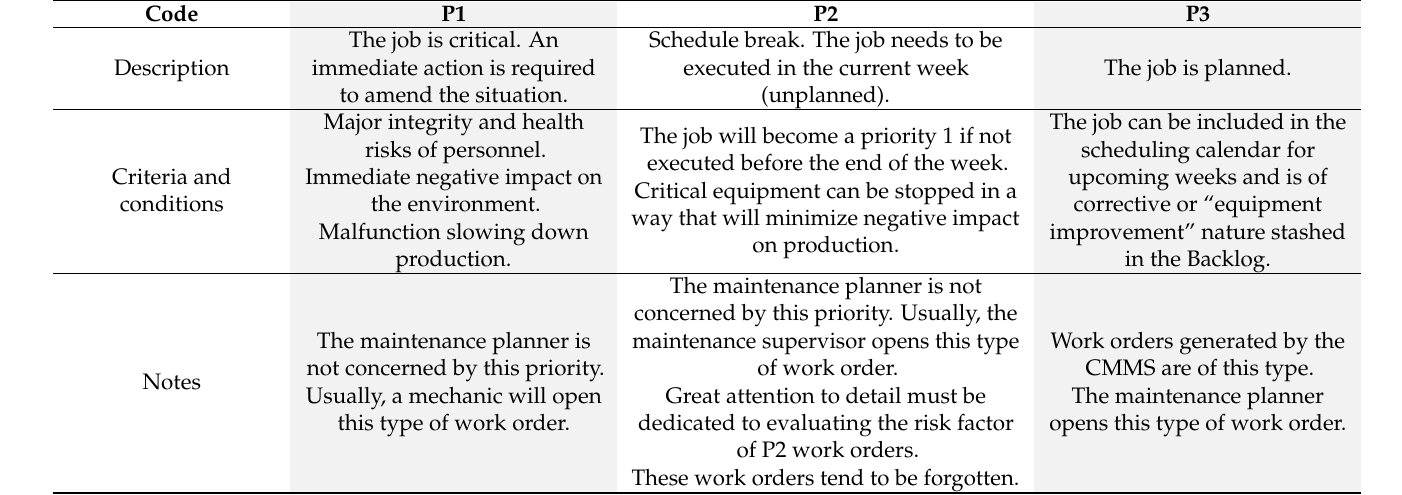
Table 2. Work order priorities and description.